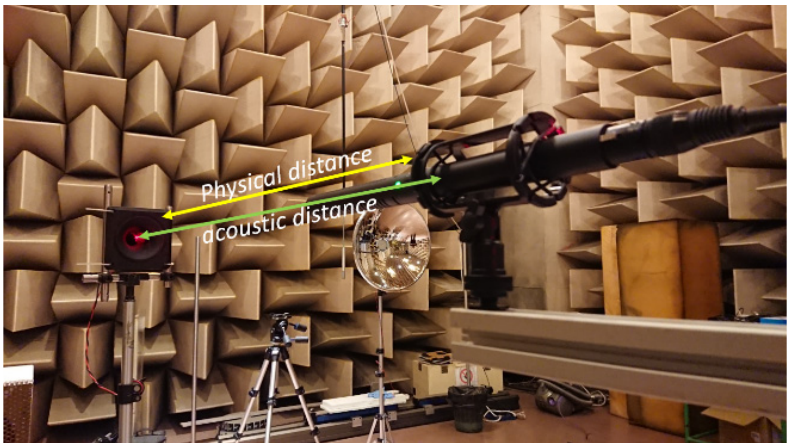
Figure 4. Picture of the experimental setup. In the foreground the directional microphone is visible. On the left hand side, the piezoelectric loudspeaker is visible. The red light dot in the loudspeaker is a laser pointer used to aim at the microphone when placed at large distances.